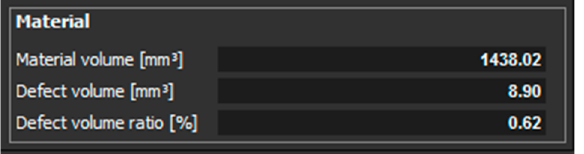
Figure 14. Measured values for a sample with 2 mm thickness, which is oriented in XZ. The identification of defects at specific locations of the sample with 3 mm thickness, which was oriented in the Z direction, is shown in Figure 15.